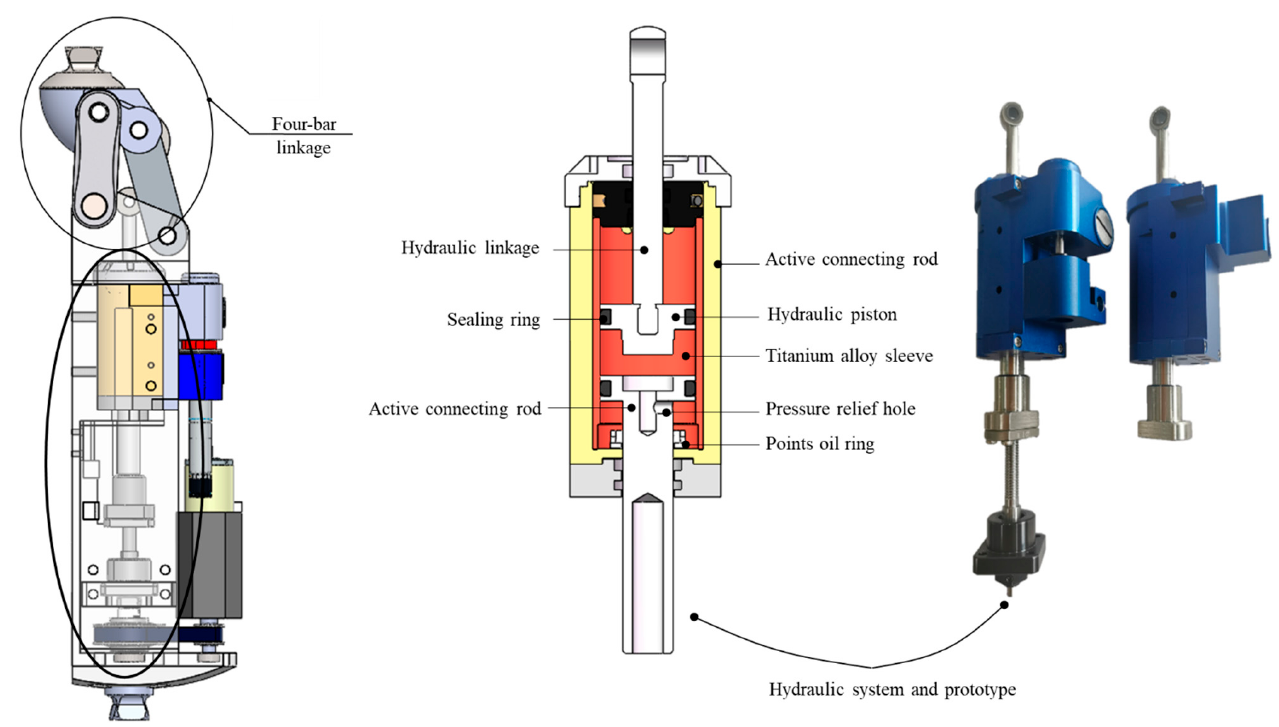
Figure 3. The active and passive structures of the prosthetic knee. ( a ) The 3D model of the pros- thetic knee; ( b ) The active and passive working principle.